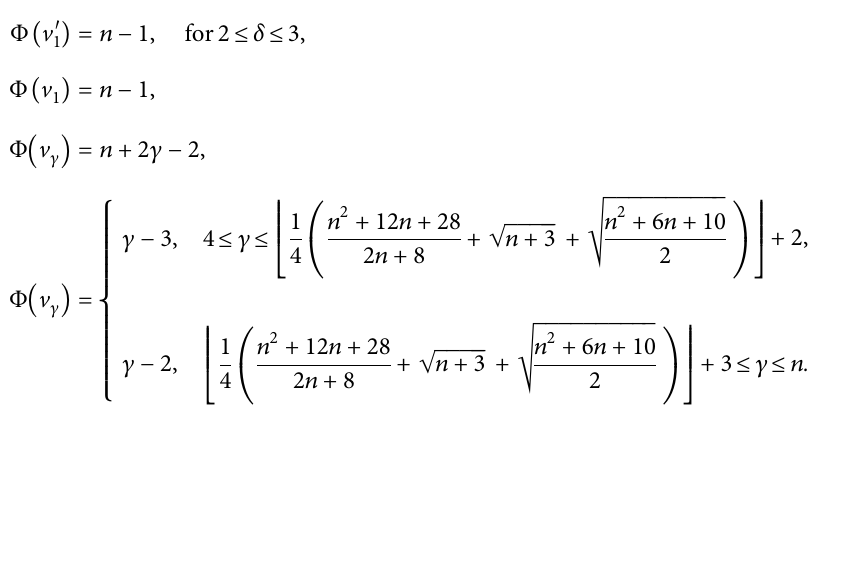
Figure 10: A classical mean labeling of the graph obtained by duplicating a vertex of a graph C